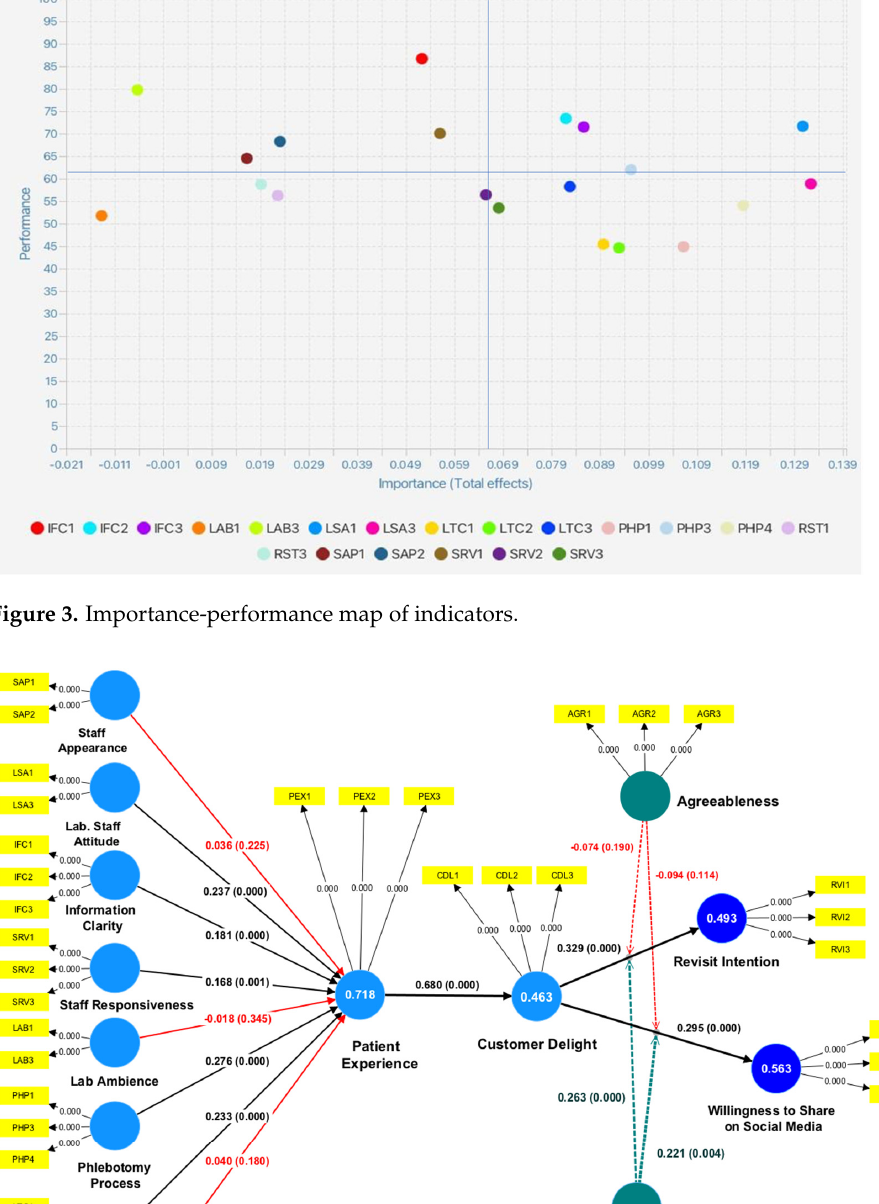
Figure 2. Simple slope analysis: ( a ) Moderation effect of OPS on the impact of CDL to RVI; ( b ) Mod- eration effect of OPS on the impact of CDL to WSP.